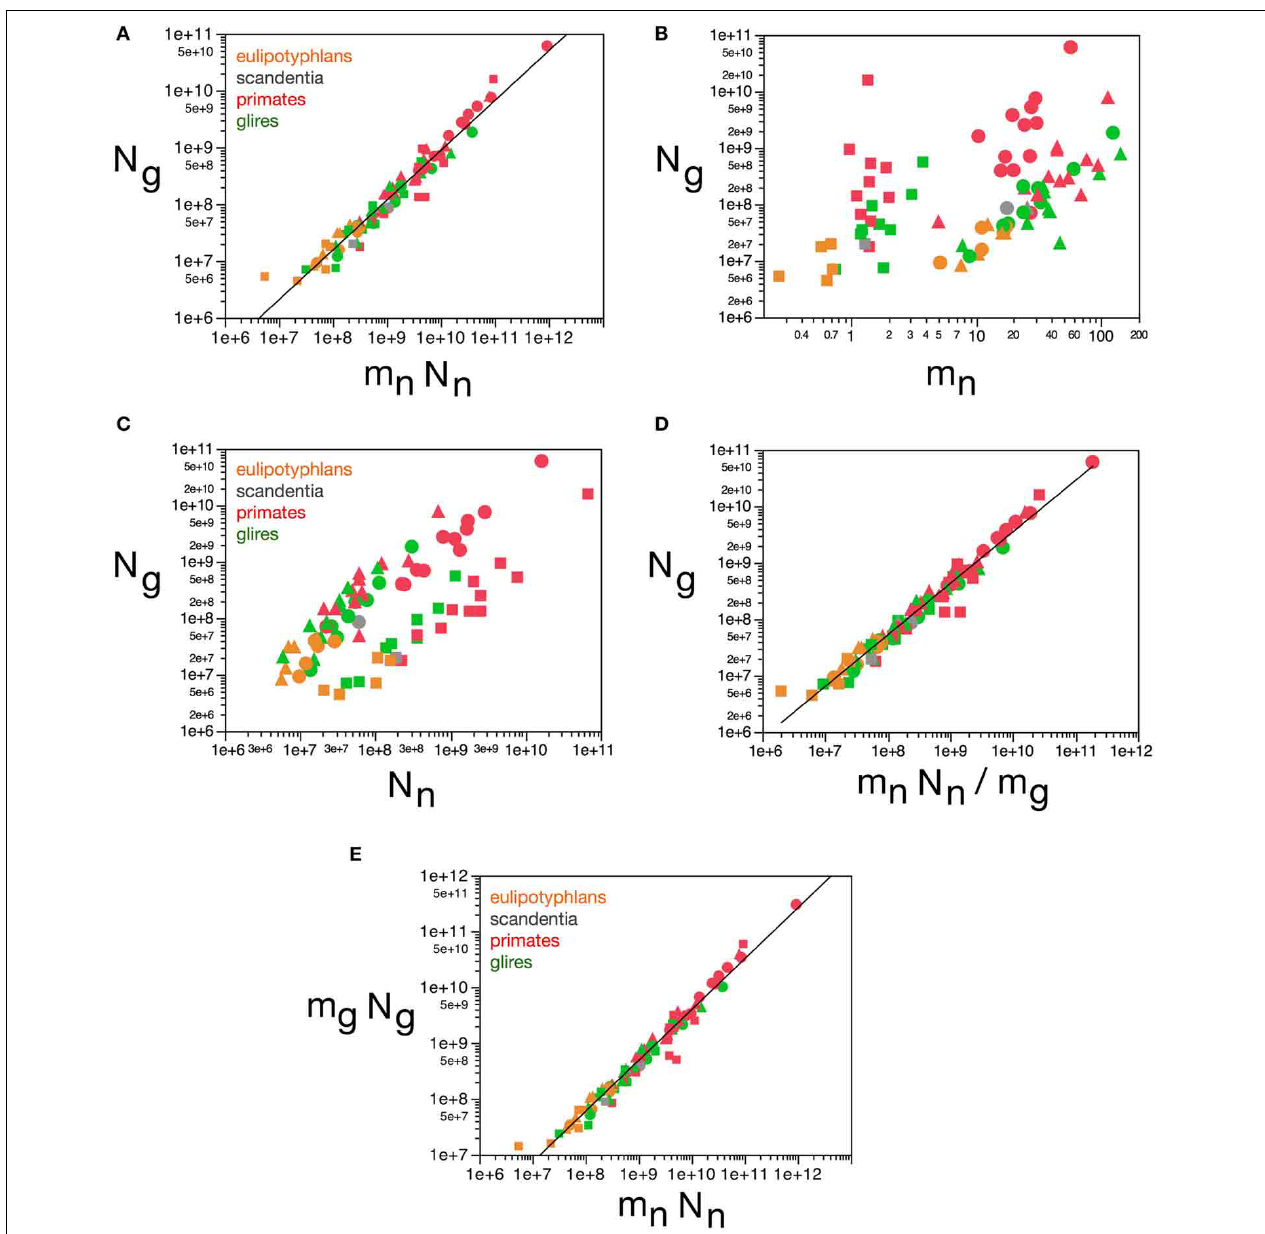
FIGURE 12 | Glial cell mass scales to match neuronal cell mass across brain structures and species. Graphs show numbers of glial cells ( N g ) in each brain structure in each species plotted (A) as a function of total neuronal mass ( m n N n ), (B) as a function of estimated average neuronal cell mass ( m n ), (C) as a function of number of neurons in the structure ( N n ), (D) as a function of the neuronal mass per glial cell in the structure ( m n N n /m g ). (E) Total glial mass in each structure ( m g N g ) varies as a function of total neuronal mass in the structure ( m n N n ). Notice that numbers of glial cells in brain structures are well predicted by variations in total neuronal mass in the